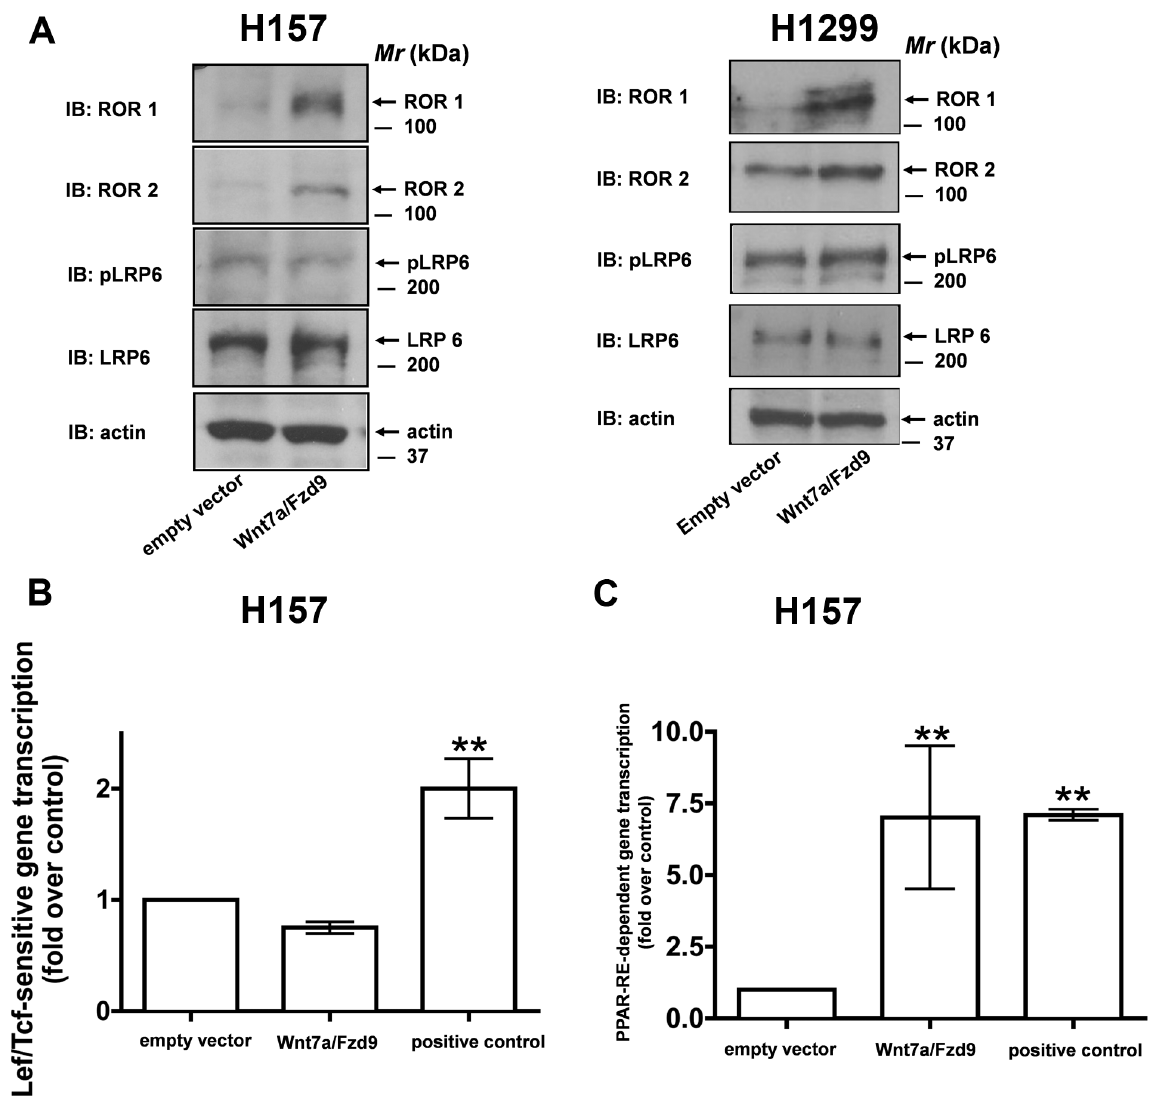
Figure 6. Wnt7a/Fzd9 signaling regulates ROR1/2 expression. A, H157 and H1299 cells were either transfected with empty vector or with Wnt7a and Fzd9 expression vectors. After 48 h, the cell lysates were probed for the expression of ROR1, ROR2, pLRP6 ser1490, and LRP6. Equal loading of proteins were ascertained by probing the blots with anti- b -actin antibodies. H157 cells were transfected with either empty vector or Wnt7a and Fzd9 expression vectors along with either M50-TOPFLASH luciferase reporter (B) or PPAR-RE-luciferase reporter (C). Positive controls used in M50- TOPFLASH reporter experiments is the b -catenin expression vector and in the case of PPAR-RE-luciferase vector is the PPAR c expression vector. After 48 h, the lysates were assayed for luciferase activities as described in the Methods. Data represents mean 6 SEM of three separate experiments. **, p , 0.01; versus empty vector control.